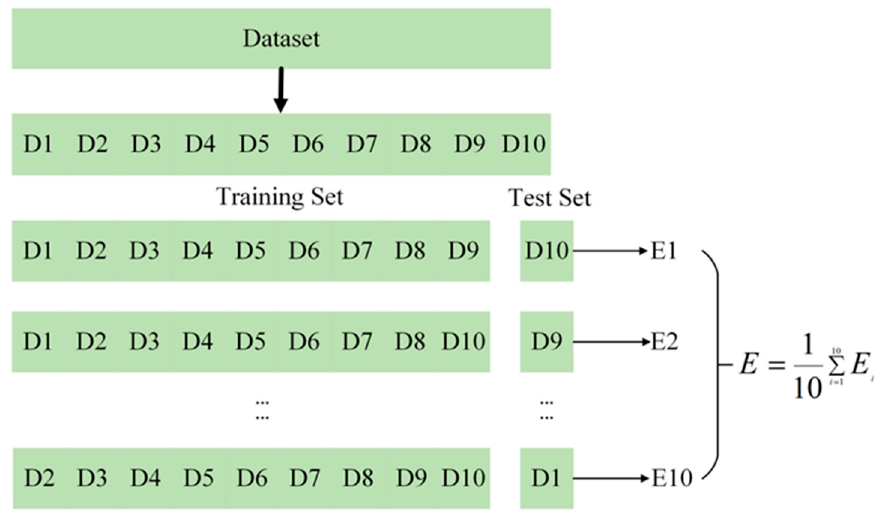
Figure 4. Schematic of the 10-fold, cross-validation. Table 3. Optimal hyperparameters for the seasonal models.